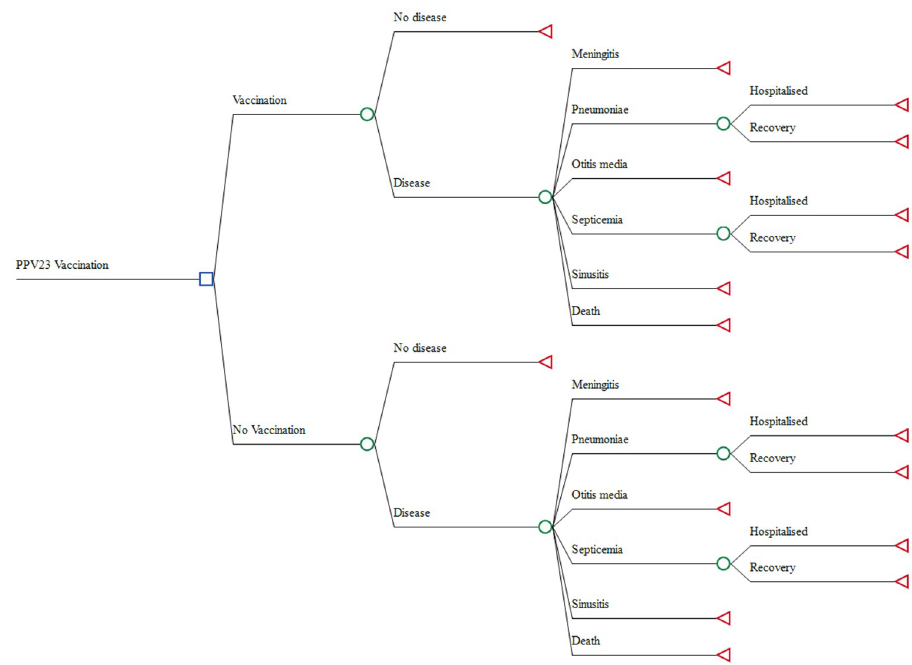
Fig 1. A decision tree model, illustrating the two alternatives for PPV23 vaccination with the status quo of no vaccination. The spectrum of pneumococcal infections included: meningitis, pneumonia, otitis media, septicemia, sinusitis and death.